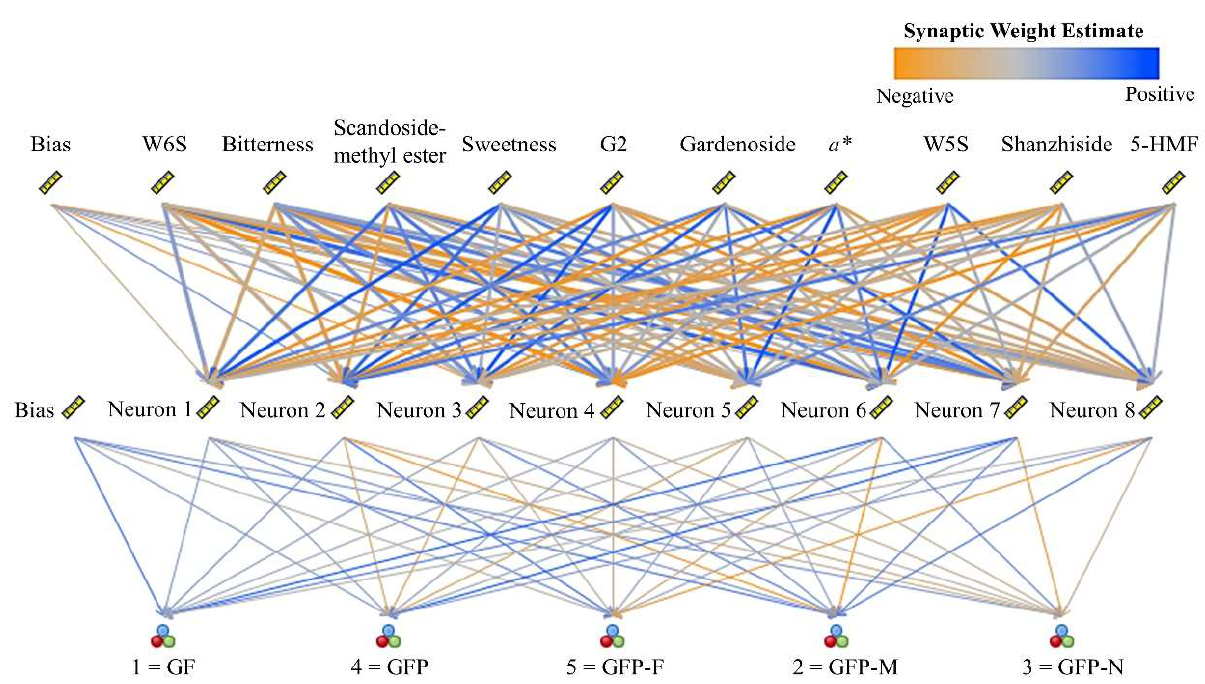
Figure 8. Artificial neural network for classification of five GFP processed decoction pieces.